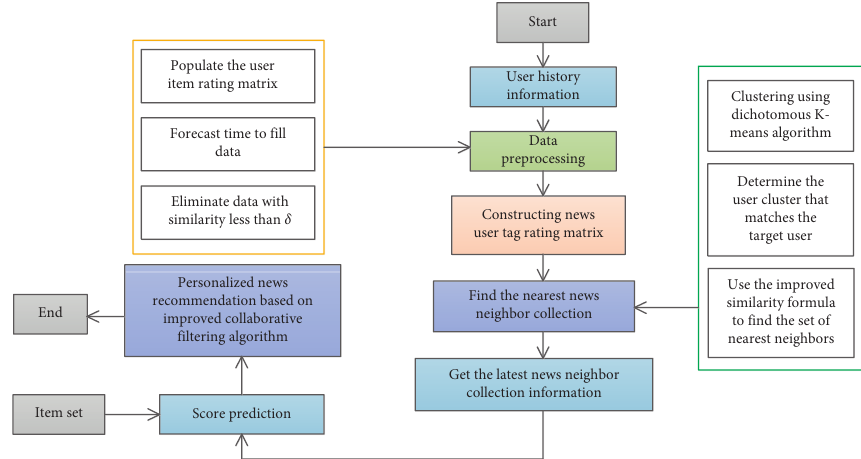
Figure 4: Improved collaborative filtering algorithm flow chart.